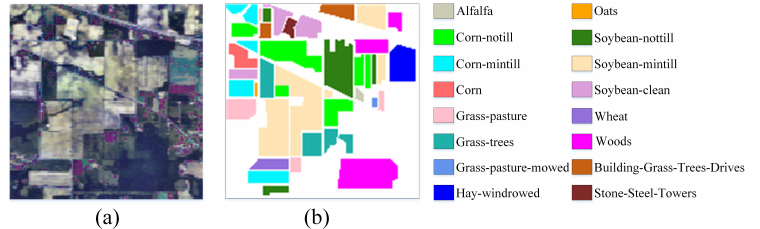
Figure 6. The IP dataset. ( a ) False-color image. ( b ) Ground-truth map.